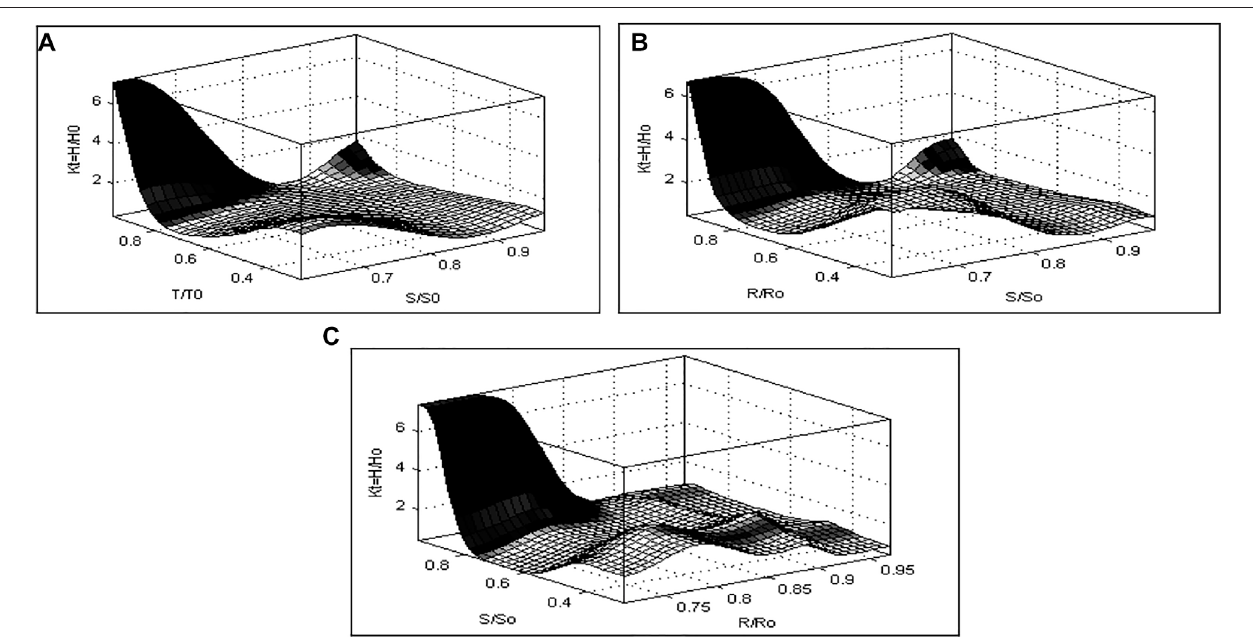
FIGURE 13 | (A – C) Surface plots combining two most important parameters for Bhubaneswar, Kolkata, and Vizag.